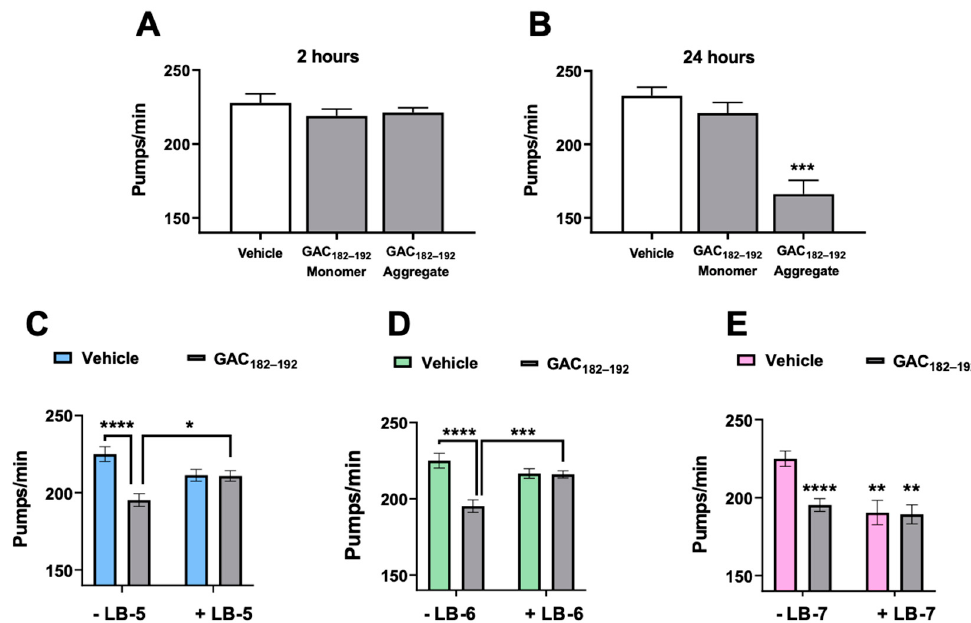
Figure 3. Effect of peptidomimetics on the toxicity caused by GAC 182–192 in C. elegans . ( A , B ) GAC 182–192 was dissolved at 100 µ M in 200 mM sodium citrate buffer, pH 4.5, containing 100 mM NaCl. An aliquot was withdrawn immediately after the dissolution (Monomer) and 48 h after the incubation at 37 ◦ C (Aggregate). Samples were then diluted in 10 mM phosphate buffered saline, pH 7.4, to the final concentration of 20 µ M and administered to C. elegans (50 µ L/50 worms). Control worms were treated in the same experimental condition with 10 mM phosphate buffered saline, pH 7.4 (50 worms/50 µ L) (Vehicle). The pharyngeal activity was determined 2 and 24 h after treatment by determining the number of pharyngeal bulb contractions (pumps/min). Data are means ± SE (N = 10). *** p < 0.001 vs. Vehicle, one-way ANOVA, and Bonferroni’s post hoc analysis. ( C – E ) GAC 182–192 (100 µ M) in 200 mM sodium citrate buffer, pH 4.5, containing 100 mM NaCl, was incubated for 48 h at 37 ◦ C in the absence or presence of 10 µ M LB-5, LB-6 or LB-7. At the end of incubation, samples were diluted five times and 20 µ M GAC 182–192 + 2 µ M peptidomimetic was administered to worms (50 worms/50 µ L). Control worms were treated with 20 µ M GAC 182–192 , 2 µ M LB-5, LB-6, or LB-7 alone, or 200 mM sodium citrate buffer, pH 4.5 (50 worms/50 µ L). The pharyngeal activity was determined 24 h after treatment. Data are means ± SE (N = 10). * p < 0.05, ** p < 0.005, *** p < 0.001, and **** p < 0.000.1, one-way ANOVA and Bonferroni’s post hoc analysis. Interaction GAC 182–192 /LB-5: p = 0.001, GAC 182–192 /LB-6: p = 0.0003, two-way ANOVA, and Bonferroni’s post hoc